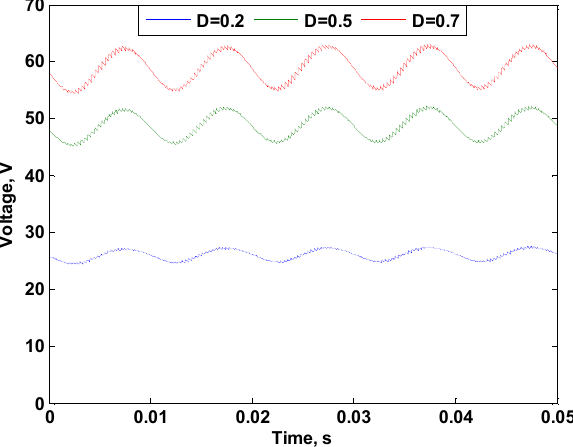
Figure 36. Experimental first-stage capacitor voltages.